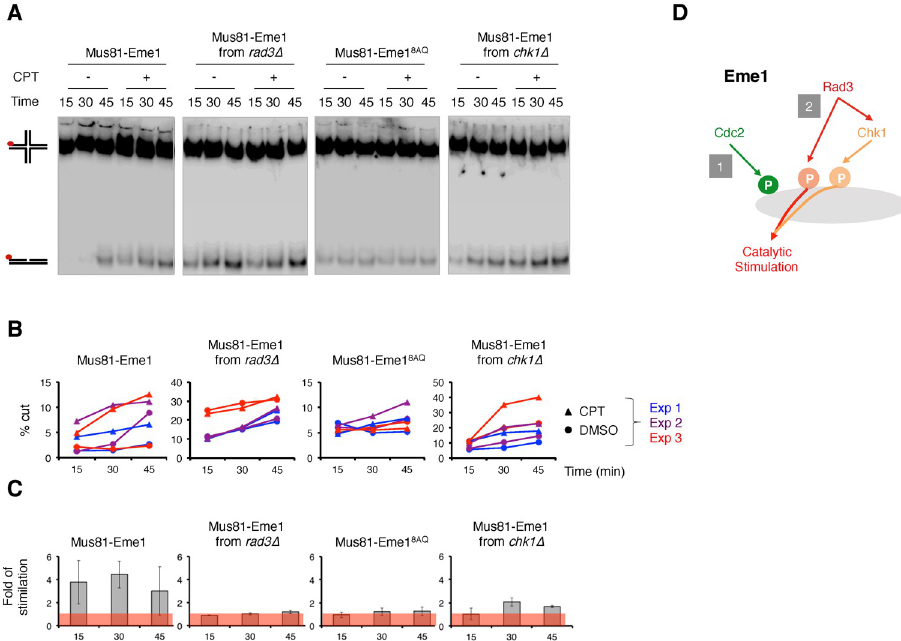
Fig 4. Rad3 ATR phosphorylation of Eme1 contributes to the catalytic stimulation of Mus81-Eme1 resolvase activity. A- 32 P-labeled (red dot) HJs were incubated for the indicated times with wild type Mus81–Eme1 or mutant Mus81-Eme1 8AQ complexes recovered from untreated or 40 μ M CPT–treated WT, rad3 Δ , eme1 8AQ or chk1 Δ mutant cells as described in Materials and Methods. Reaction products were analyzed by neutral PAGE. Comparable amounts of protein samples were used in each reaction after normalization of their relative concentration (see Materials and Methods and S3A Fig ). B- Quantification of product formation, represented as a percentage of total radiolabeled DNA, in three independent experiments including the one in (A) (See S3A, S3B, S3C, S3D and S3E Fig ). C- Average ( ± s.d.) fold stimulation of HJ resolution by Mus81–Eme1 following CPT–treatment (n = 3 independent experiments, see S3 Fig ). The histogram shows the ratio of the HJ-resolvase activity of Mus81–Eme1 from CPT-treated cells over that of Mus81–Eme1 from untreated cells. D- Model for the Cdc2 CDK1 -, Rad3 ATR - and Rad3 ATR -Chk1-dependent phosphorylation of Eme1 and DNA damage-induced catalytic